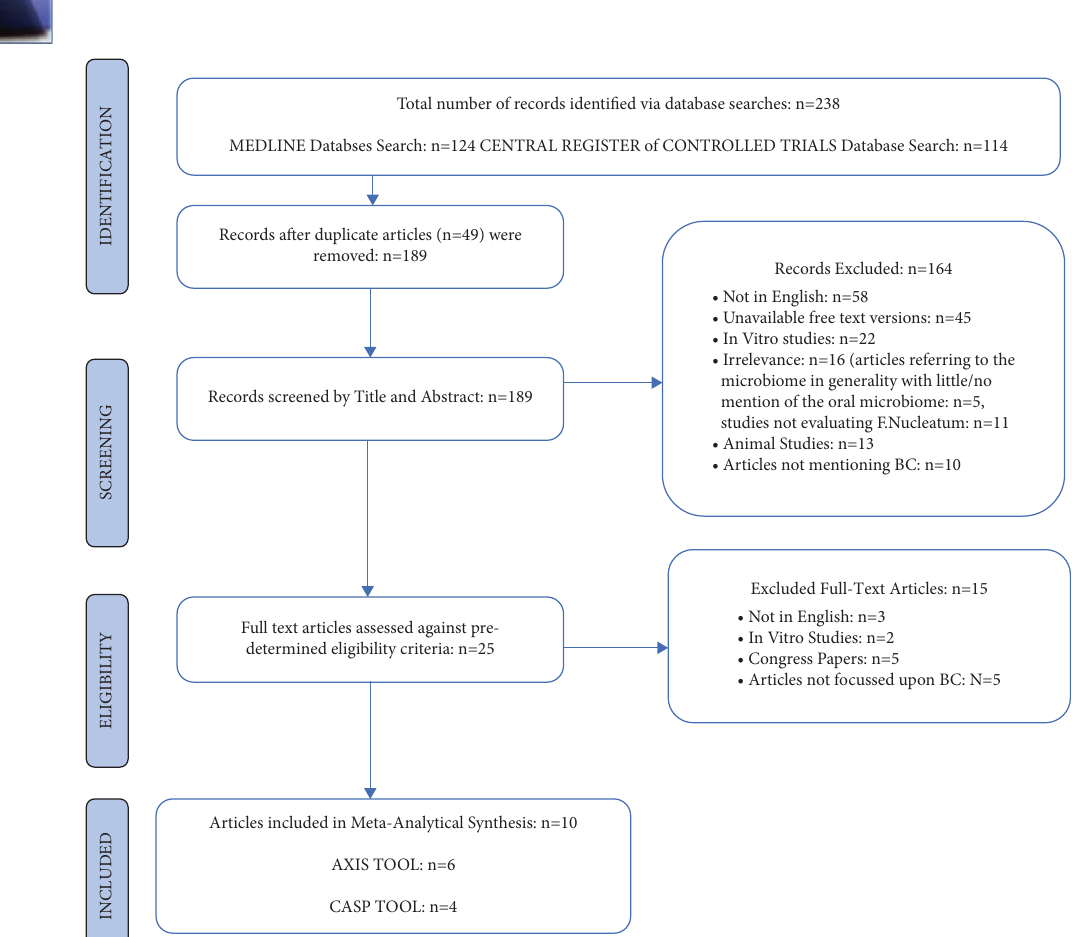
Figure 3: Te PRISMA fow diagram outlines the search and selection process applied in preparation for this